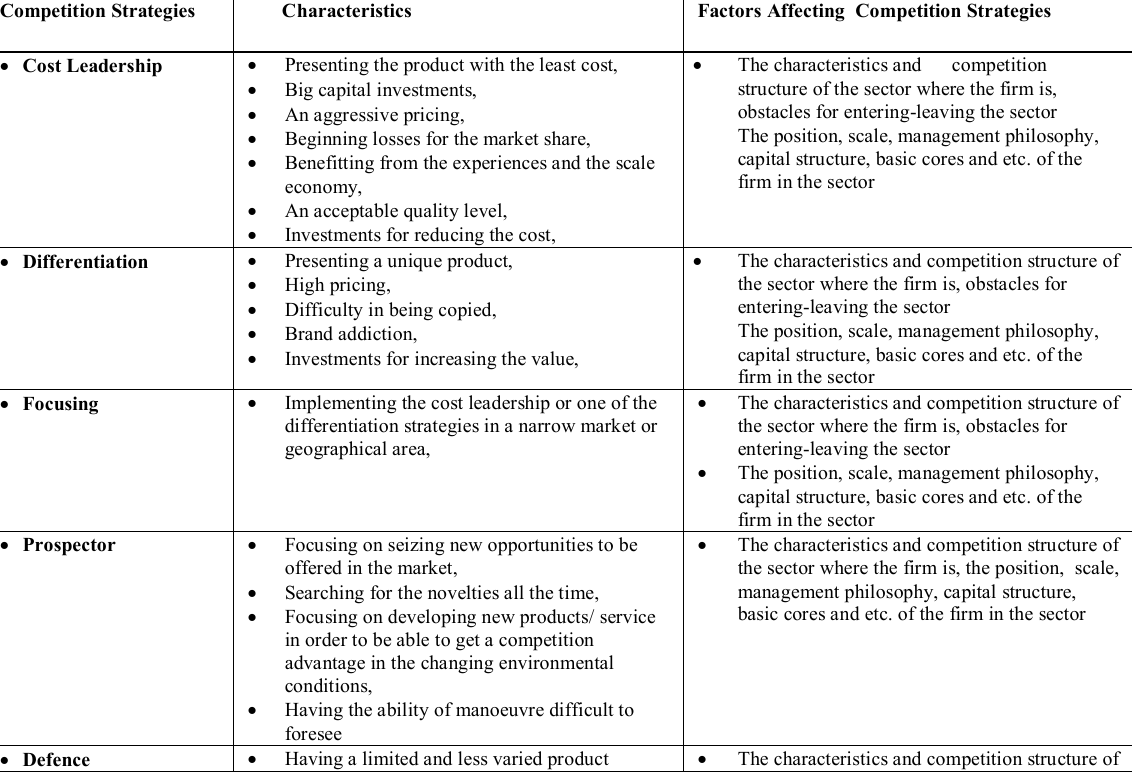
Table 2: Basic Competition Strategies, Their Characteristics and Factors Affecting the Competition Strategies Competition